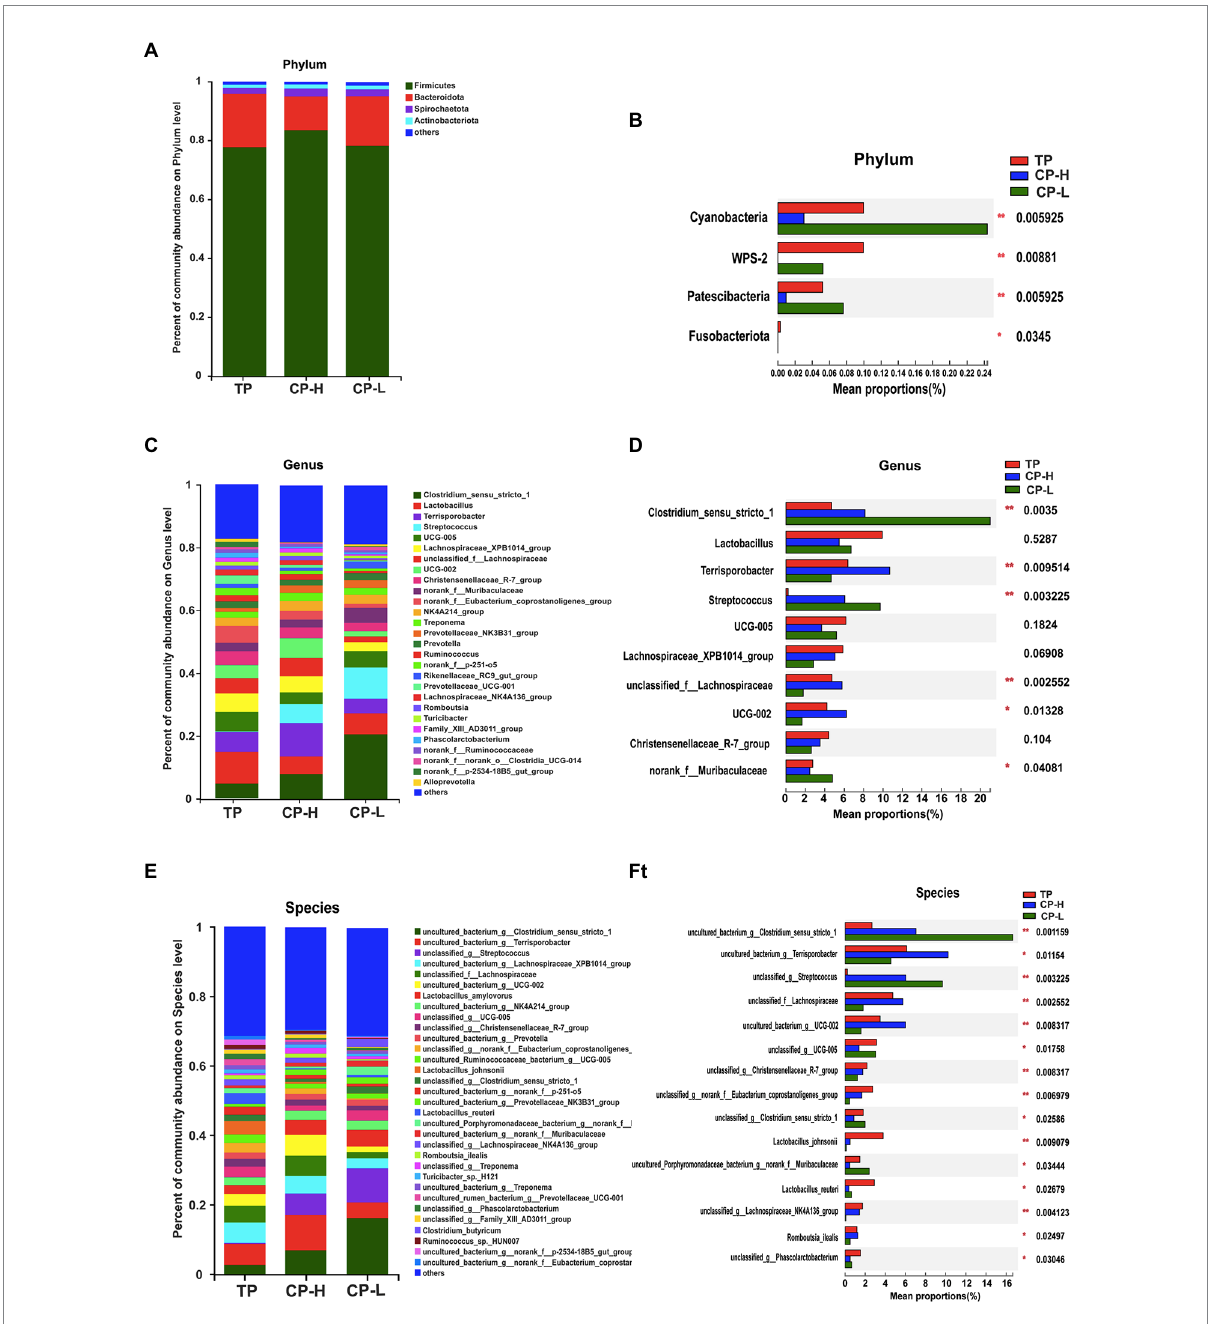
FIGURE 4 Effects of high-altitude hypoxic environment on gut microbiota community composition in the colonic chyme of pigs. TP: positive control group, CP-H: treatment group, CP-L: negative control group. (A) The relative abundances of microbiota in colonic chyme at the phylum level. (B) Analysis of variance the gut microbiota with significant differences at the phylum level. (C) The relative abundances of microbiota in colonic chyme at the genus level. (D) Analysis of variance about relative abundance of the top 10 genera in the three groups. (E) The relative abundances of microbiota in colonic chyme at the species level. (F) Analysis of variance about relative abundance of the top 15 genera with significant differences at the species level. Data are expressed as mean ± SEM ( n = 6). * indicating a statistically significant difference ( p < 0.05), ** indicating a highly significant difference ( p <